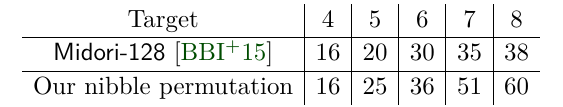
Table 6: Comparison of lower bounds of the number of active